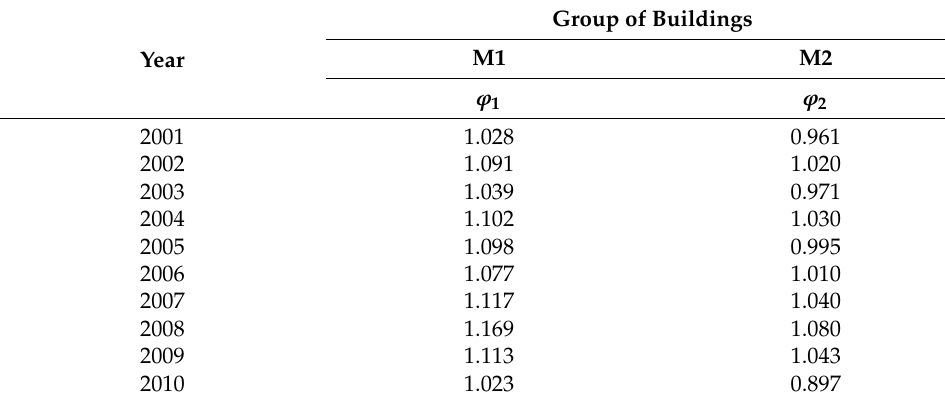
Table 6. Values of the ϕ 1 and ϕ 2 correction factors.